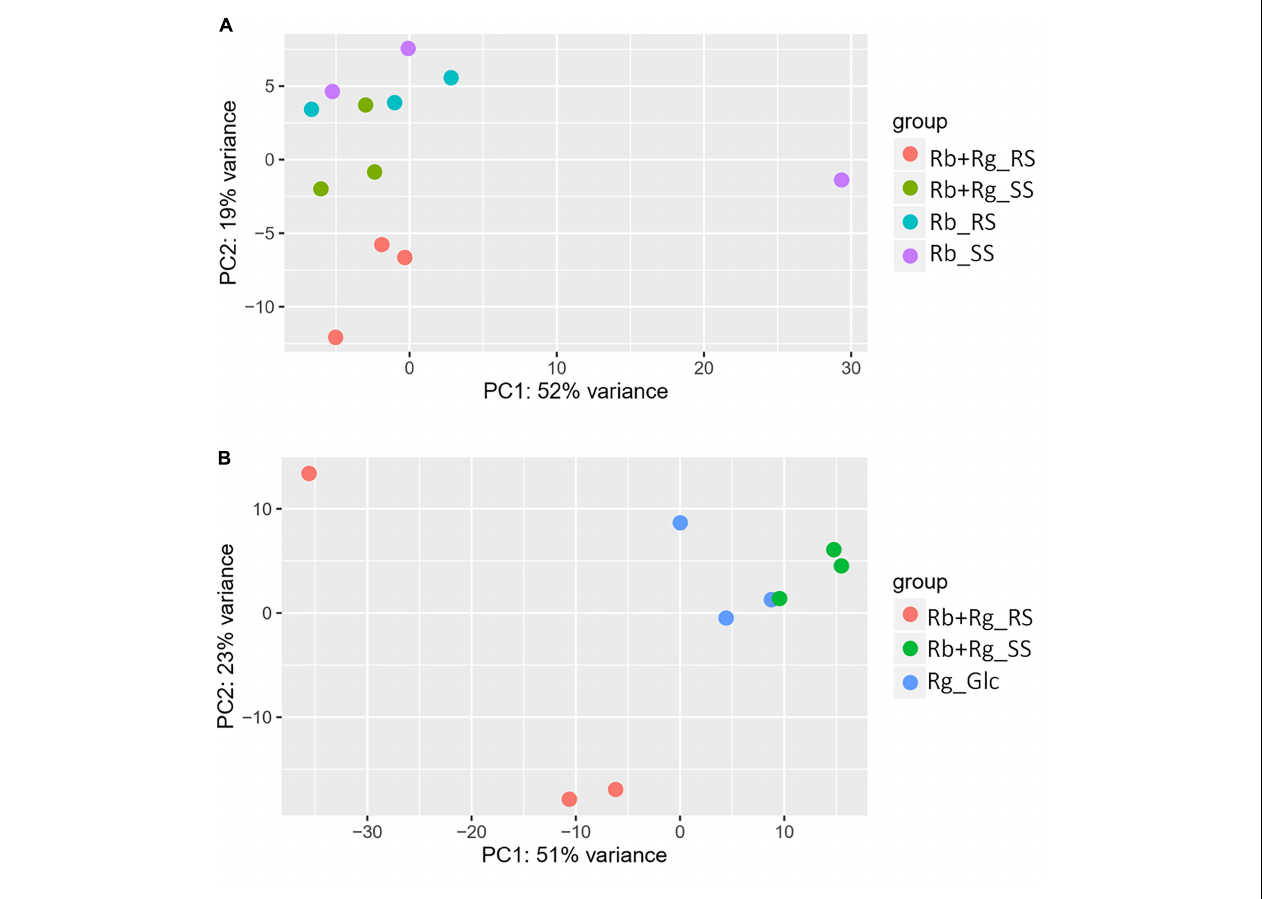
FIGURE 4 | Principal component analysis (PCA) plots for transcriptomics data of R. bromii L2-63 genes (A) and R. gnavus ATCC 29149 genes (B)